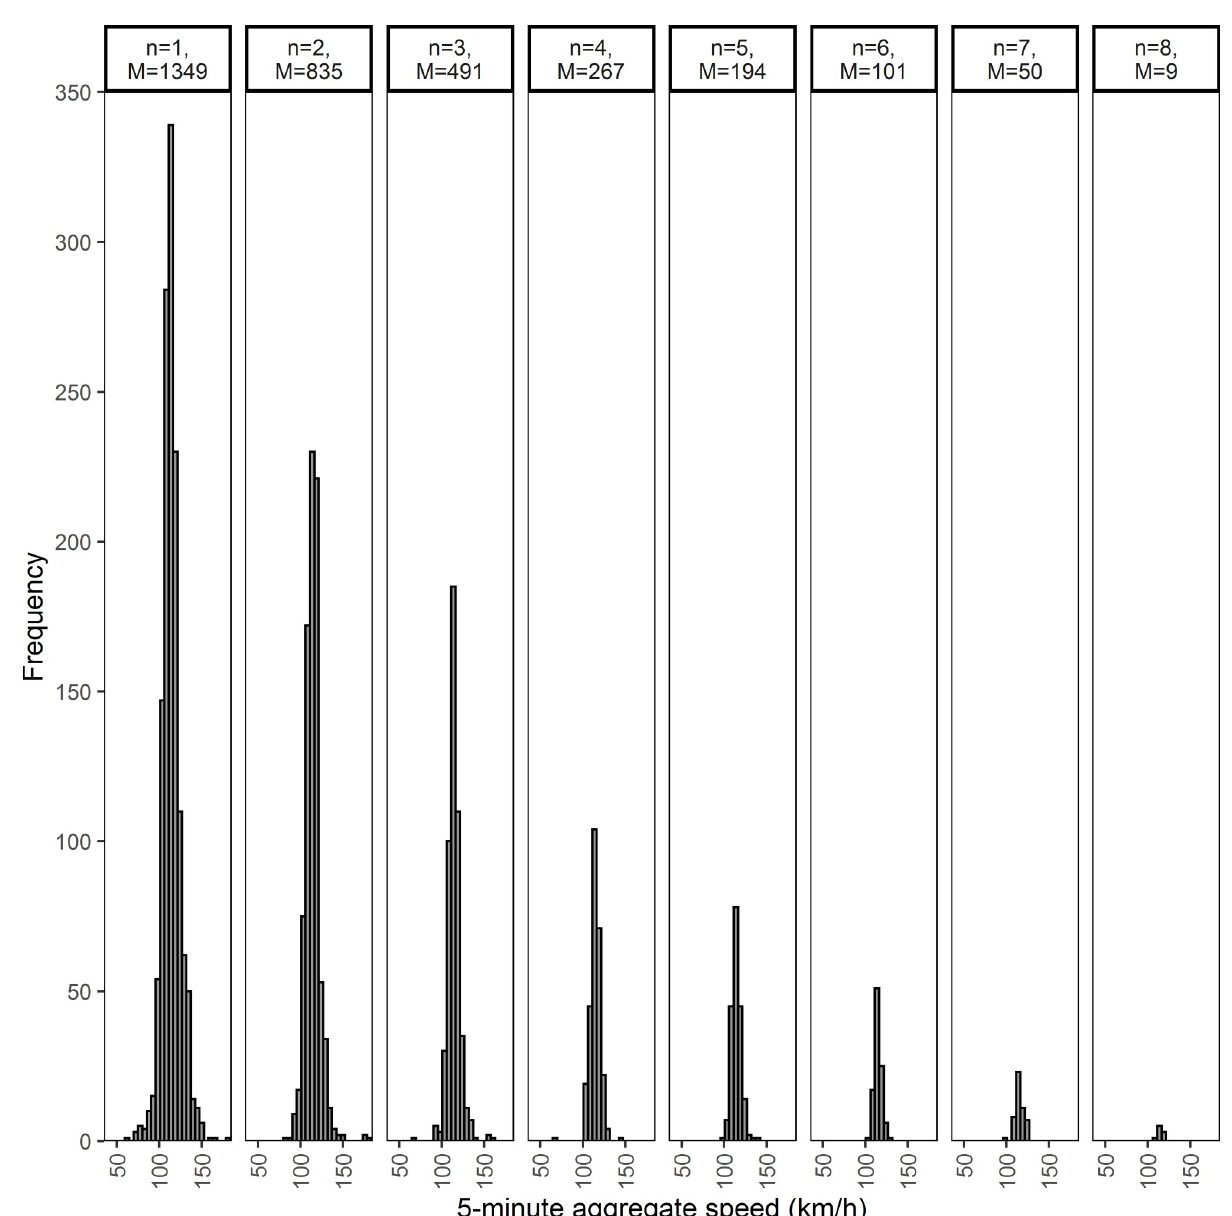
Fig 7. Sampling distribution of mean speeds for a population represented by eight sampling distributions (population ID: D-NP-N-T:GIII-TF: GI-HV:GI).